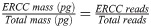
ERCC reads to determine library preparation quality and back-calculate RNA input mass.(A) After normalizing to RNA input mass, reads aligning to the 92 ERCC spike-in transcripts correlate linearly with ERCC spike-in concentration across six orders of magnitude in all libraries prepared with the miniaturized protocol (R2 = 0.9319). (B) The initial sample input mass can be calculated using the ratio of ERCC reads to total sequencing reads in each sample using the equation: ERCCmass(pg)Totalmass(pg)=ERCCreadsTotalreads Back-calculated masses of HeLa libraries correlated strongly with QuBit quantification (R2 = 0.9954).